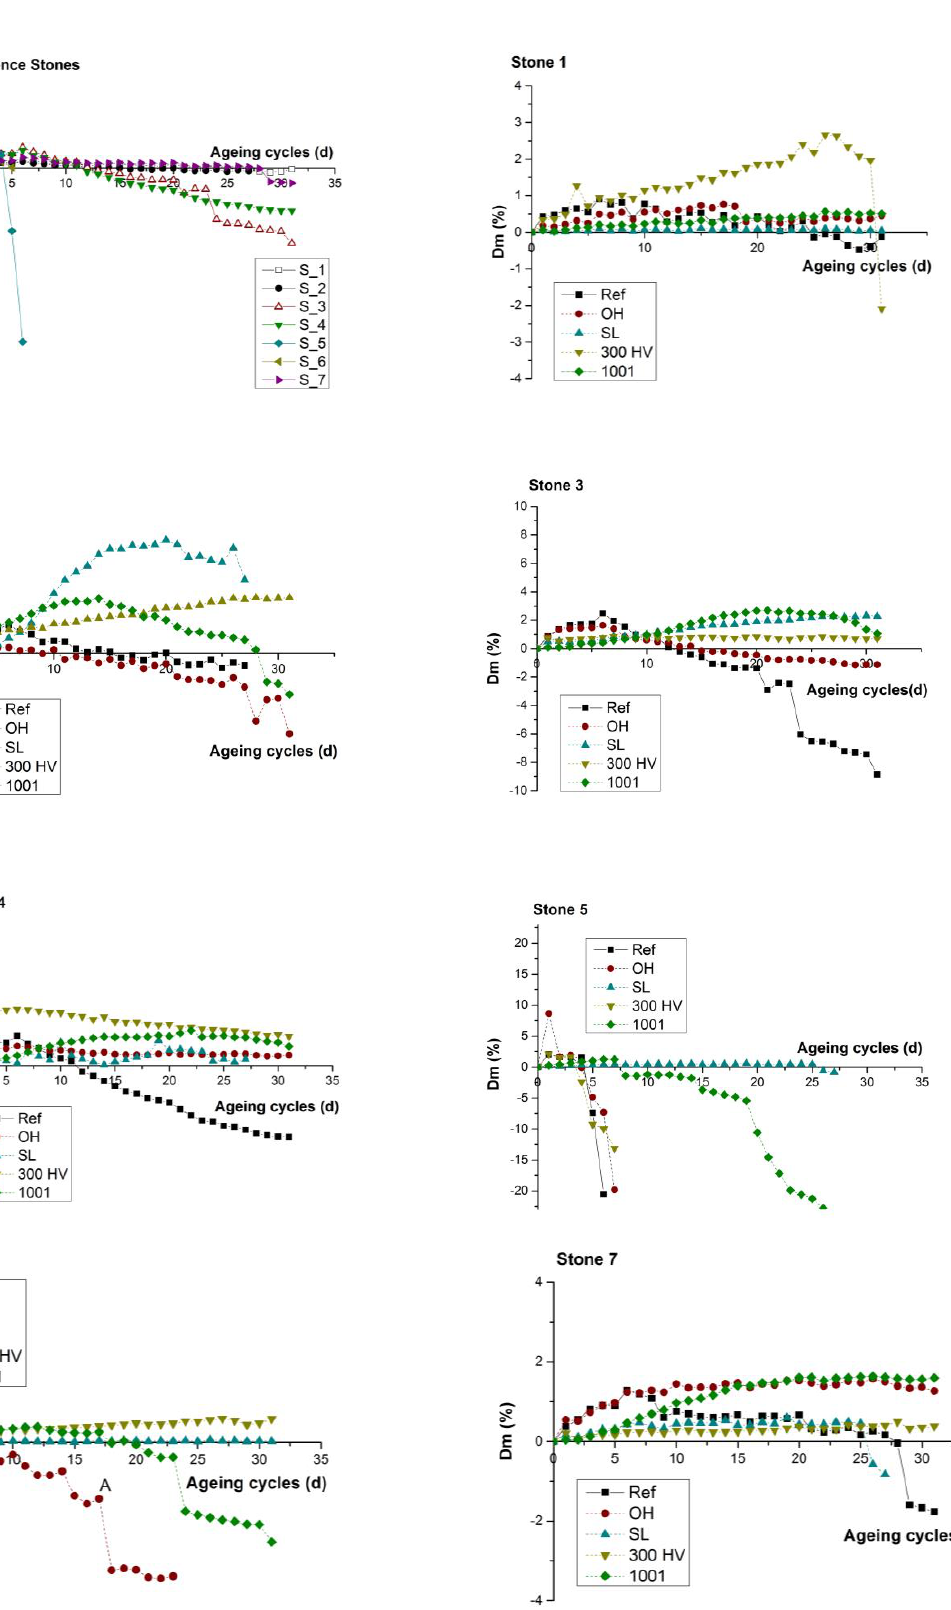
Figure 9. Weight difference (ΔW%) of both treated and untreated stone samples during the 31 operation cycles (days).